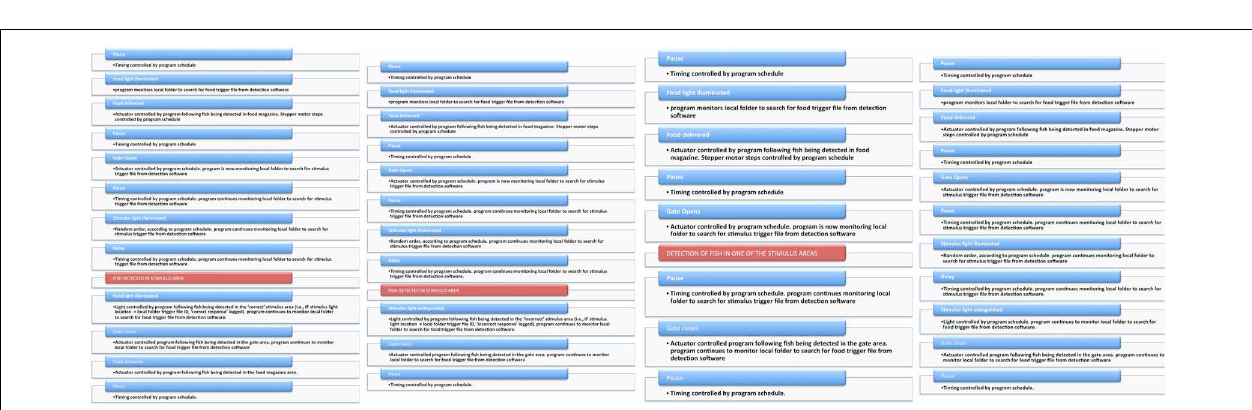
Frontiers in Systems